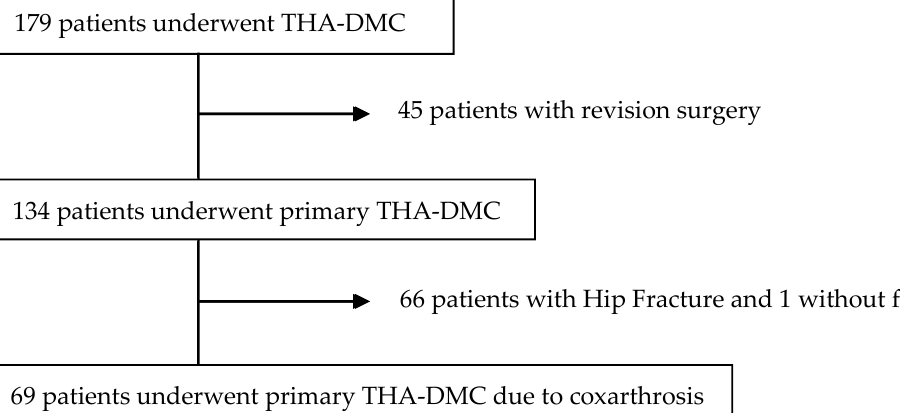
179 patients underwent THA-DMC